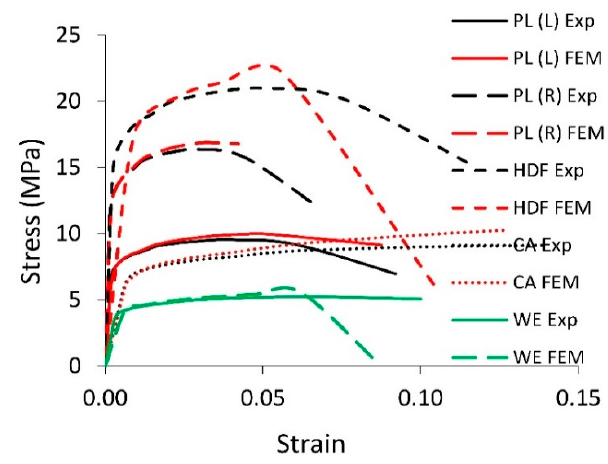
Figure 2. The stress-strain relationship for selected materials. Codes in Table 1.